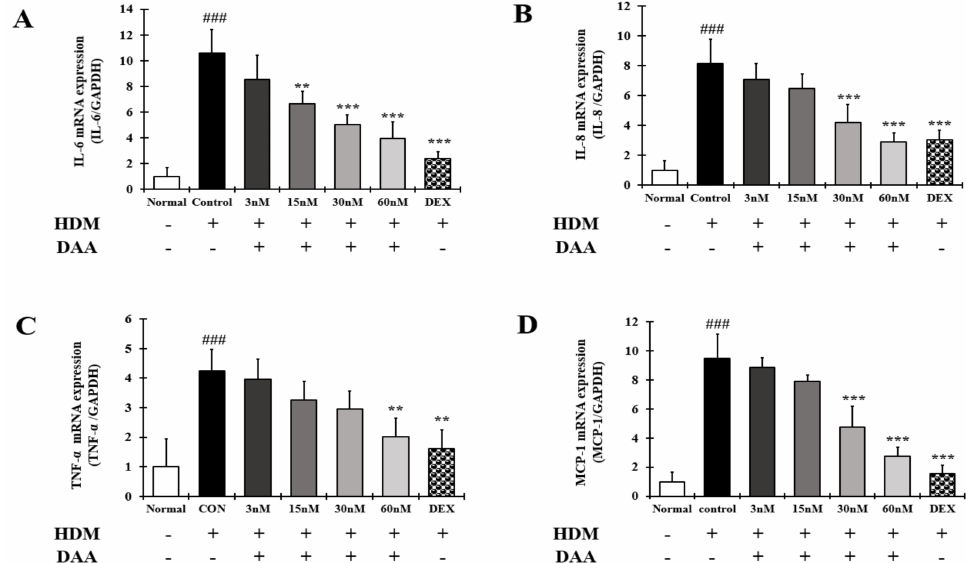
Figure 15. Effect of DAA on the gene expression levels of AD-related cytokines and chemokines in EOL-1 cells. The gene expression levels of IL-6 ( A ), IL-8 ( B ), TNF- α ( C ), and MCP-1 ( D ) are shown. Total RNA was isolated from EOL-1 cells and analyzed by RT-qPCR. The expression levels were normalized to that of GAPDH. The results are expressed as the mean ± SD (n = 4). ### p < 0.001 vs. normal; ** p < 0.01 and *** p < 0.001 vs. control. DAA was used at 3 nM, 15 nM, 30 nM, and 60 nM. DEX, the positive control, was used at 2